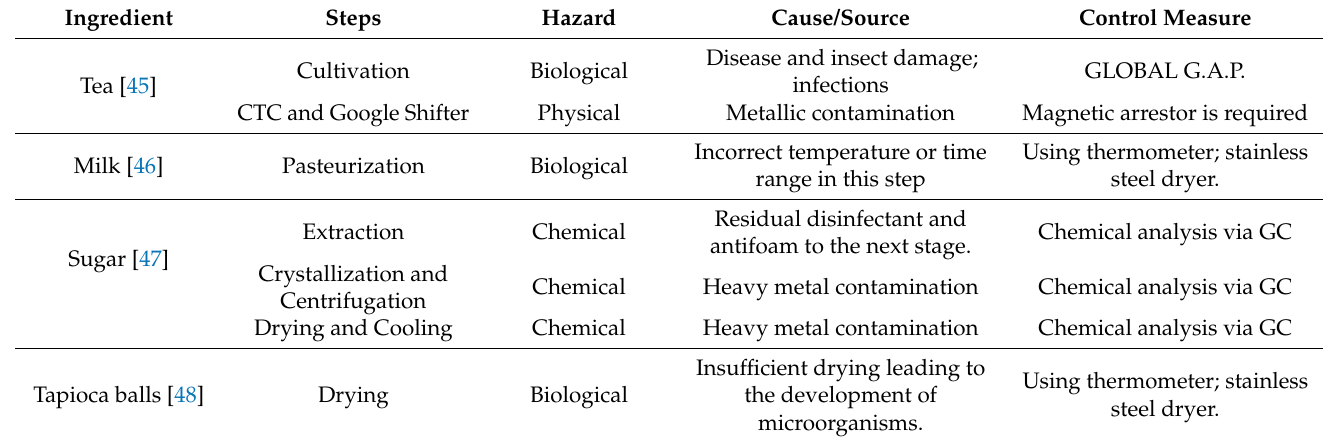
Table 2. An example of the HACCP for bubble tea ingredients.